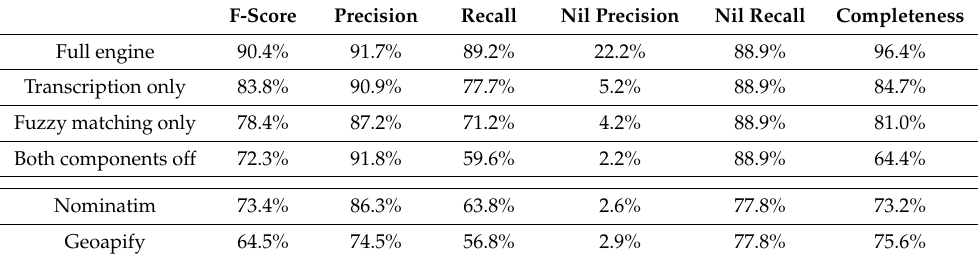
Table 2. Accuracy metrics for the developed geocoding engine and its variants with individual components turned off, compared to the third-party Nominatim and Geoapify engines. Source: our own research. F-Score Precision Recall Nil Precision Nil Recall Completeness Full engine 90.4% 91.7% 89.2% 22.2% 88.9% 96.4% Transcription only 83.8% 90.9% 77.7% 5.2% 88.9% 84.7% Fuzzy matching only 78.4% 87.2% 71.2% 4.2% 88.9% 81.0% Both components off 72.3% 91.8% 59.6% 2.2% 88.9% 64.4% Nominatim 73.4% 86.3% 63.8% 2.6% 77.8% 73.2% Geoapify 64.5% 74.5% 56.8% 2.9% 77.8%